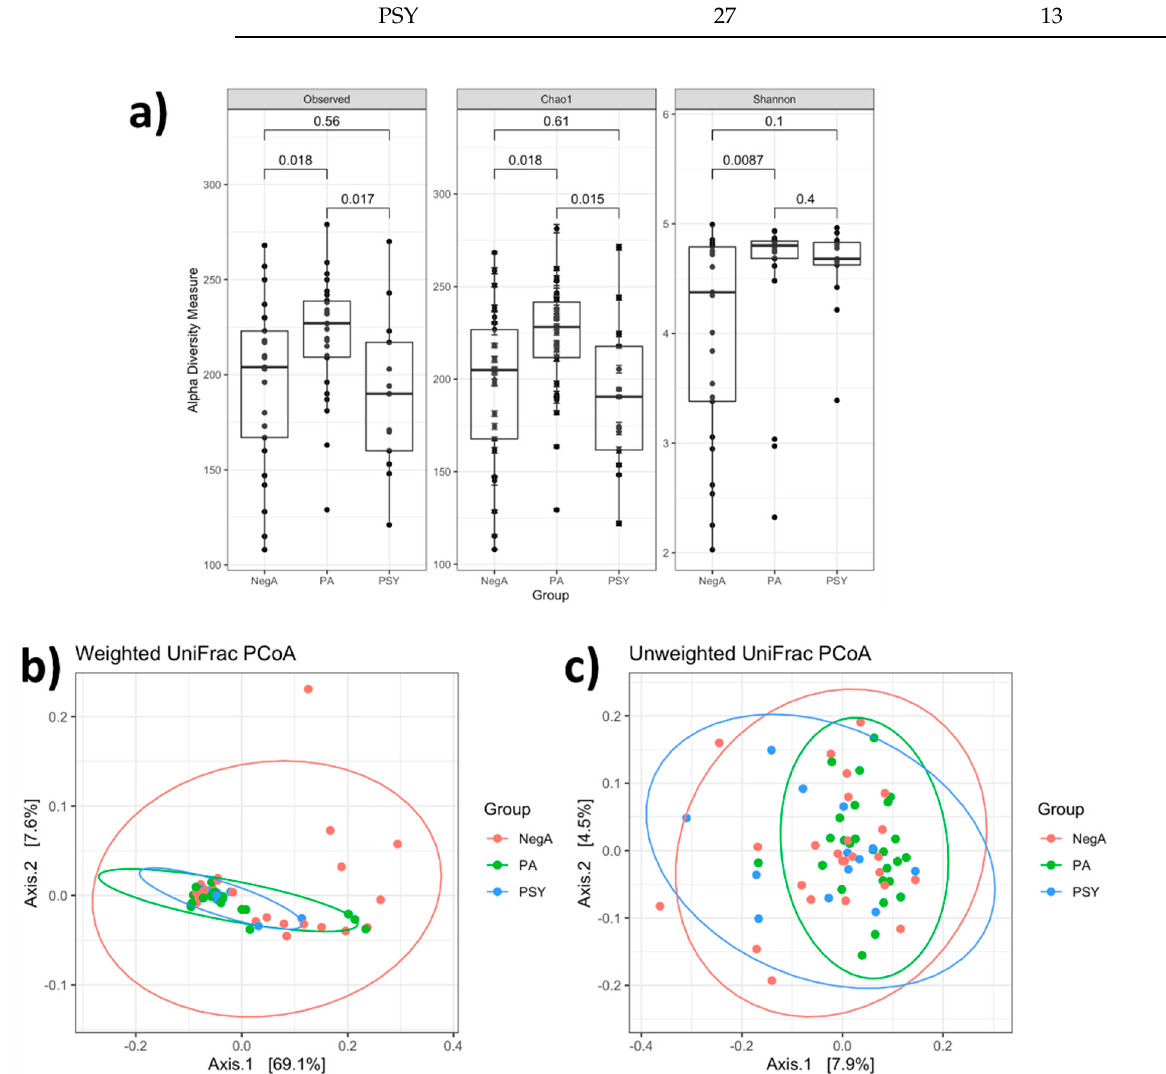
Figure 1. Alpha and beta diversity plots to visualize the difference in nasal microbiota in COVID-19 positive asymptomatic (PA) and COVID-19 positive symptomatic (PSA) patients compared to negative patients (NegA). ( a ) Alpha diversity measures with the most common indices. p-values were obtained using Wilcoxon test. The line in the middle of the box, bound of the box, and whiskers represent the median, 25th–75th percentiles, and min-to-max values, respectively. First two axes of PCoA show ( b ) unweighted and ( c ) weighted UniFrac distances from the beta diversity of study groups. Each dot represents an individual sample. Beta diversity depicting differences in the bacterial community among groups was tested by pairwise permutational multivariate analysis of variation (PERMANOVA; Adonis function in vegan).